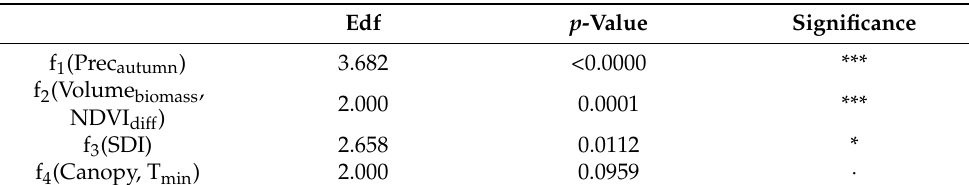
Table 2. Parameters describing the smoother functions, where the significance codes are for a